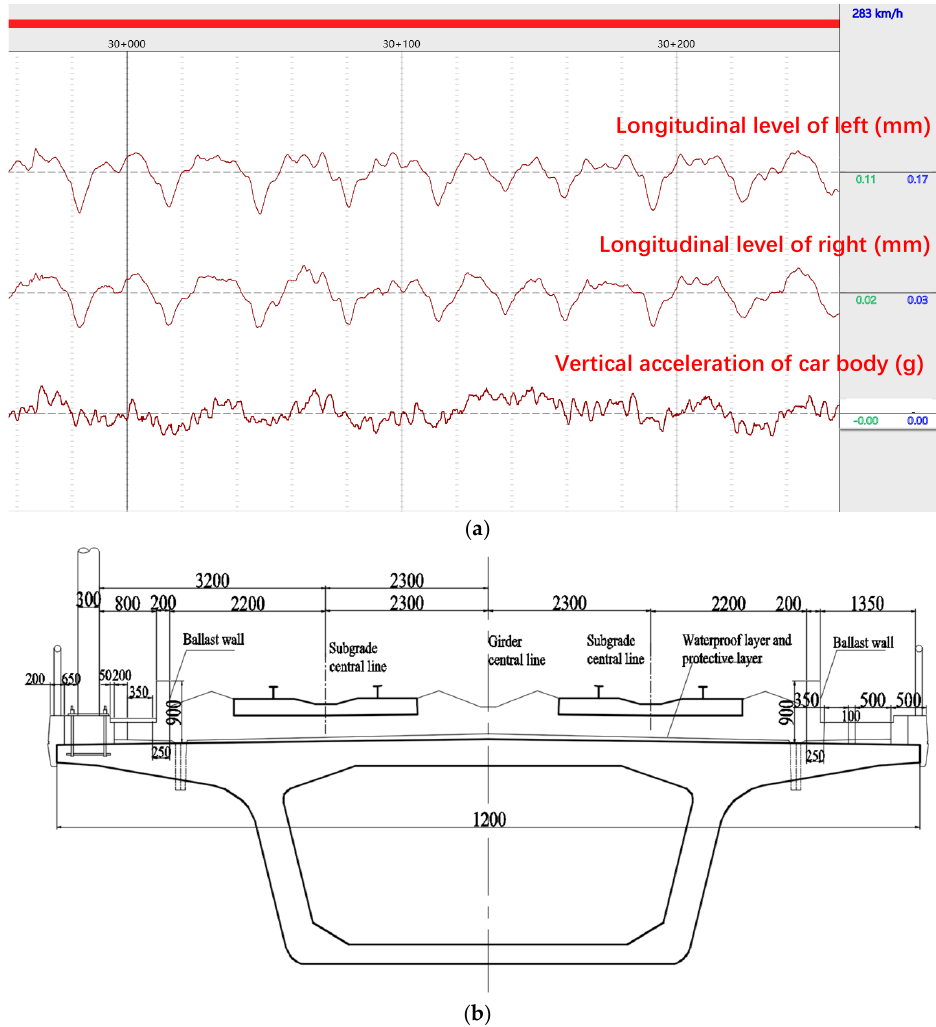
Figure 1. Track geometric irregularity and cross-section arrangement of HSR with ballast track. ( a ) Wave of track geometric irregularity. ( b ) Diagram of cross − section